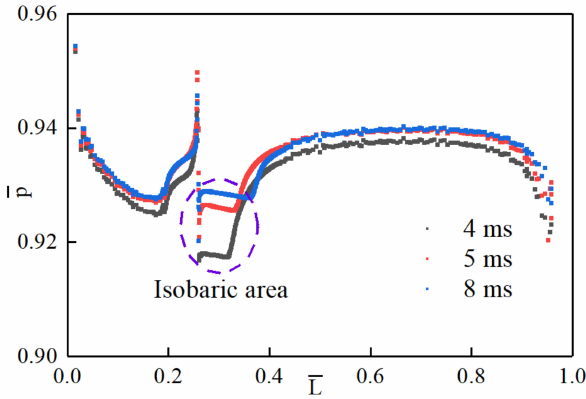
Figure 14. Schematic of the exterior of vehicle.